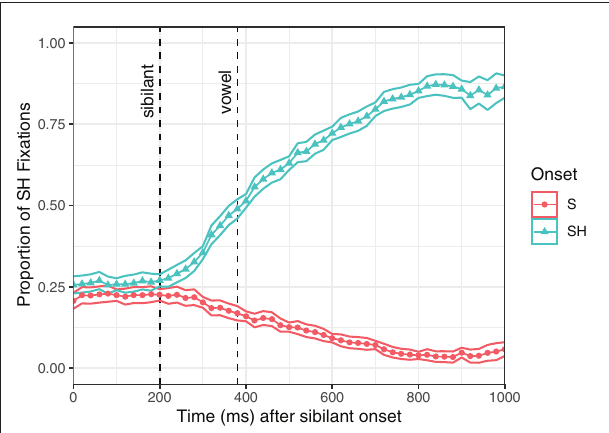
FIGURE 2 | Fixation proportion for / S / clusters (y-axis) by time following the sibilant onset (x-axis, binned into 20 ms windows) and onset category (color: /s/ = red circles, / S / = teal triangles). The vertical lines represent a 200 ms delay from the onset of the sibilant and vowel. A fixation executed during the sibilant interval would be observed between the black dashed vertical